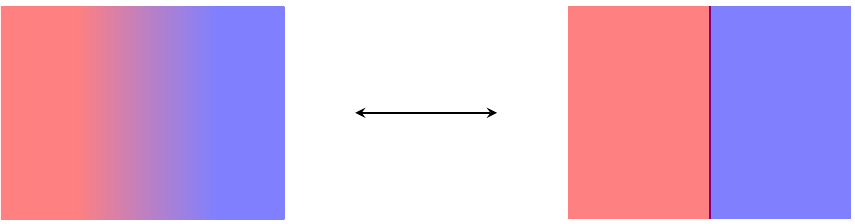
Figure 4 . A continuous interpolation between two systems can be identi(cid:12)ed with an invertible interface at a su(cid:14)ciently large